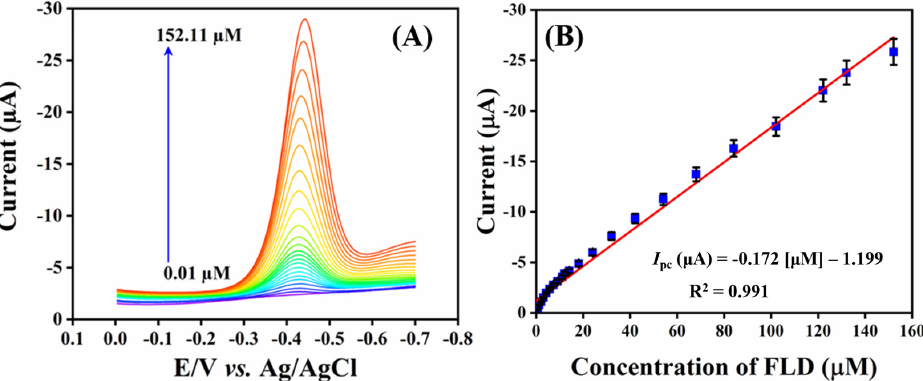
Table 1. Comparison of FLD sensors with different previously-reported modified electrodes.